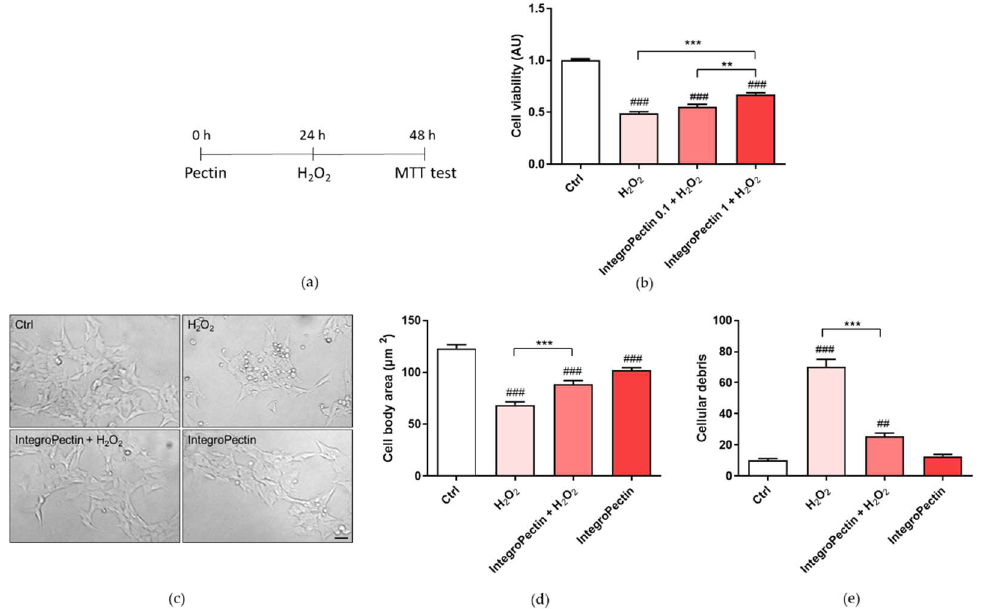
Figure 3. Effect of grapefruit IntegroPectin on cell viability and morphology of SH-SY5Y cells impaired by H 2 O 2 treatment. ( a ) Scheme of cell pretreatment with IntegroPectin; ( b ) Histogram showing cell viability of untreated cells (Ctrl) or treated with IntegroPectin or with H 2 O 2 alone or in combination with IntegroPectin ( n = 45); ( c ) Representative bright field morphological images of untreated cells (Ctrl) or treated with IntegroPectin or with H 2 O 2 alone or in combination with IntegroPectin; ( d ) Cell body area histogram of untreated cells (Ctrl) or treated with IntegroPectin or with H 2 O 2 alone or in combination with IntegroPectin ( n = 68); ( e ) Amount of cells debris per field histogram of untreated cells (Ctrl) or treated with IntegroPectin or with H 2 O 2 alone or in combination with IntegroPectin ( n = 36). Scale bar 50 µ m. Tukey test: ## p < 0.01, ### p < 0.001 as compared to control (Ctrl) group; ** p < 0.01, *** p <